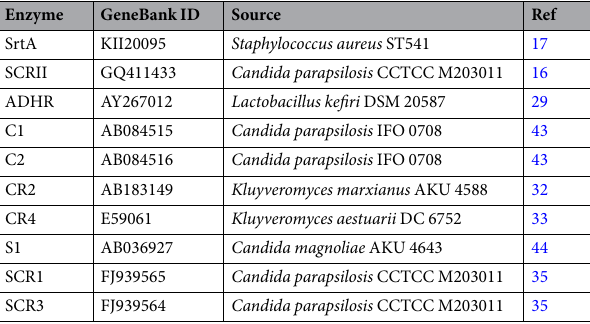
Table 1. Enzymes in this work.